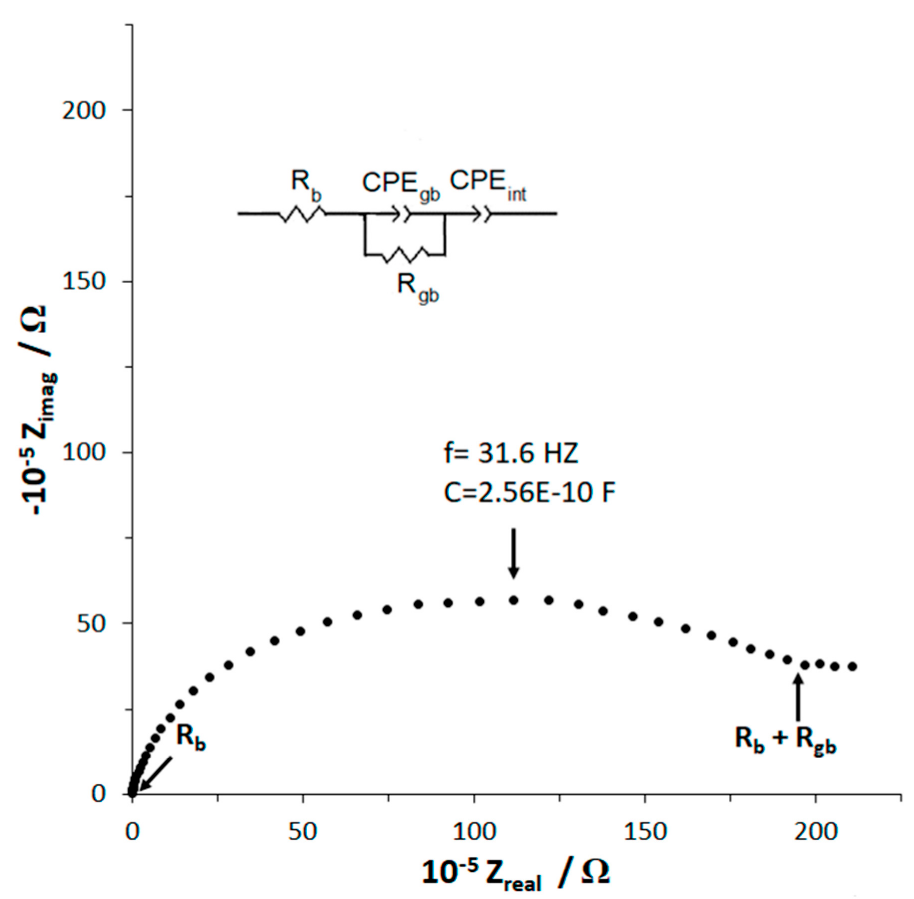
Figure 4. Room temperature impedance plot of hot-pressed Li 1.25 Cr 0.25 Ti 1.5 O 4 and the equivalent circuit used to interpret the